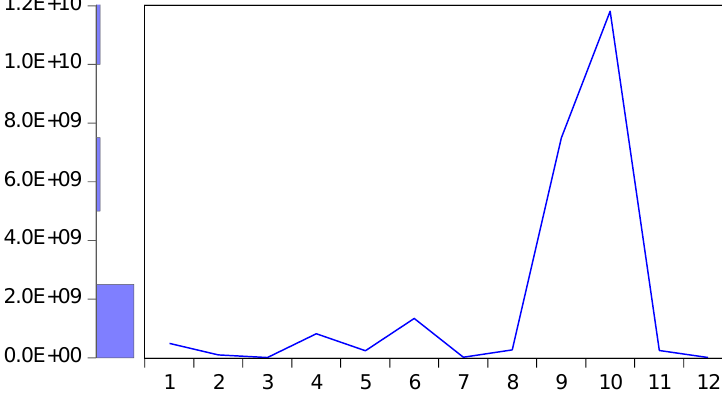
Figure 1. Market Figure 1. Market capitalization.